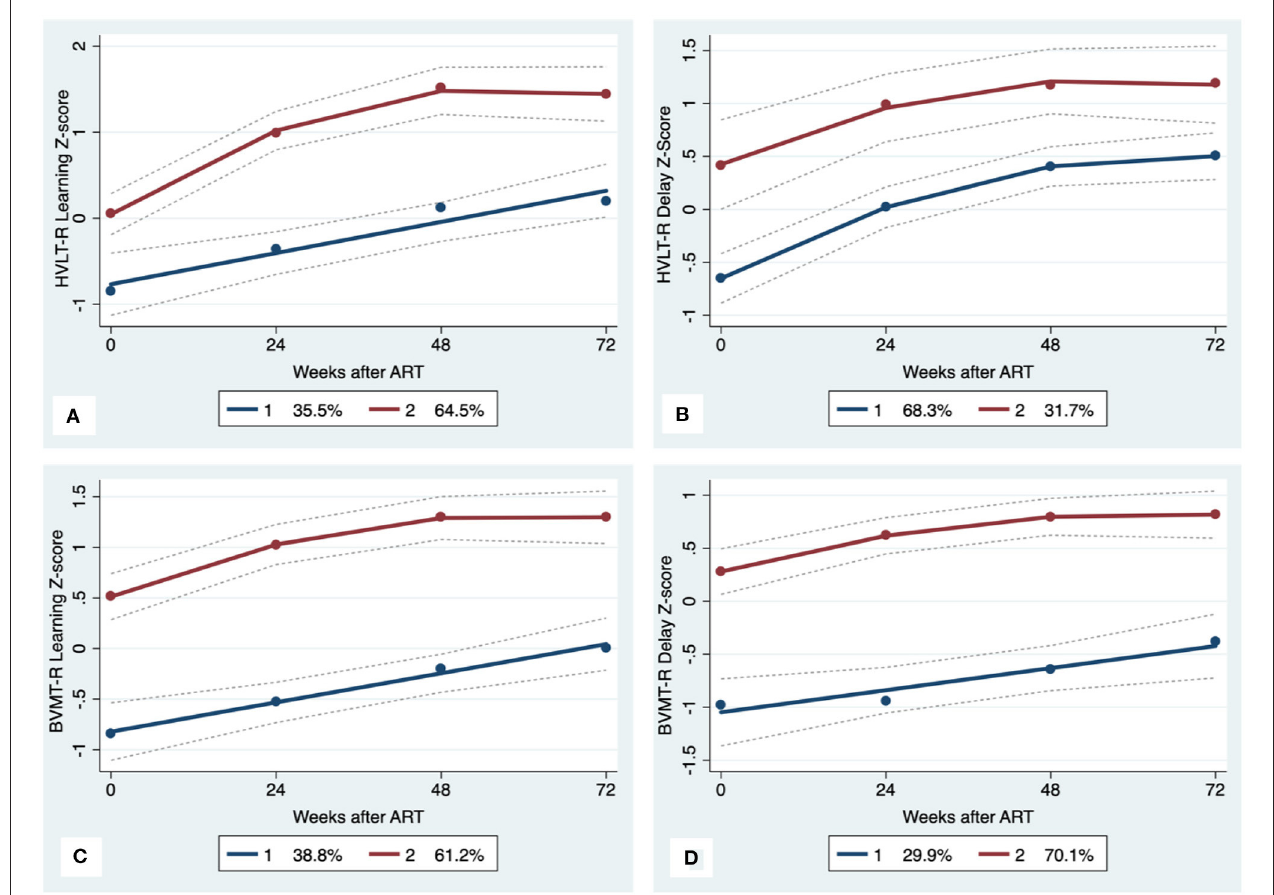
FIGURE 3 | Learning and memory trajectory groups. Solid lines represent estimated trajectories, dot symbols are observed group means at each assessment wave, and dashed lines are 95% pointwise confidence intervals on the estimated trajectories. (A) HVLT-R Learning; (B) HVLT-R Delay; (C) BVMT-R Learning; and (D) BVMT-R